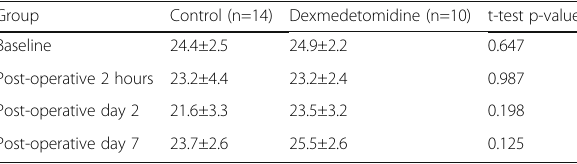
Table 2 (abstract 0064). Perfused small vessel density (mm/mm2). Repeated-measure ANOVA revealed time p=0.005, group p=0.831 and time x group